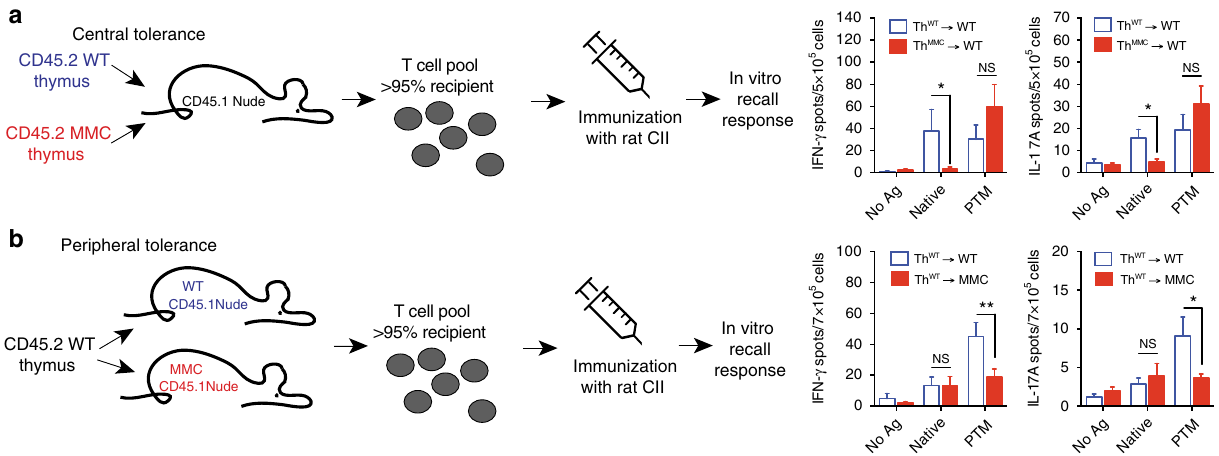
Fig. 4 mTEC-mediated central tolerance to self-CII is limited to the native epitope. a Four-week-old nude mice were grafted with neonate thymi from either WT or MMC donors ( n = 5/group). Eleven weeks later, mice were immunized with rat CII and draining lymph node cells were re-stimulated in vitro with different CII peptides. b MMC-positive ( n = 8) and MMC-negative ( n = 6) nude mice were grafted with neonate thymi from wild-type donors. Eleven weeks later, recipients were immunized with rat CII and draining lymph node cells were re-stimulated in vitro with different CII peptides. Values shown are the mean ± SEM number of spots recorded for IFN- γ -producing and IL-17A-producing cells. p values were calculated using Mann – Whitney U test. * p < 0.05; ** p < 0.01; NS not signi fi